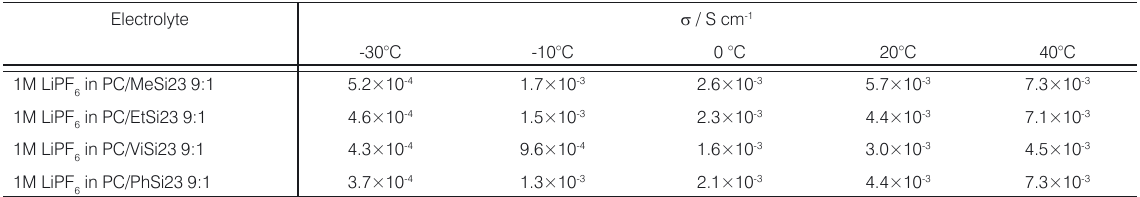
Table 2. Specific conductivities of electrolytes with supramolecular additives at selected